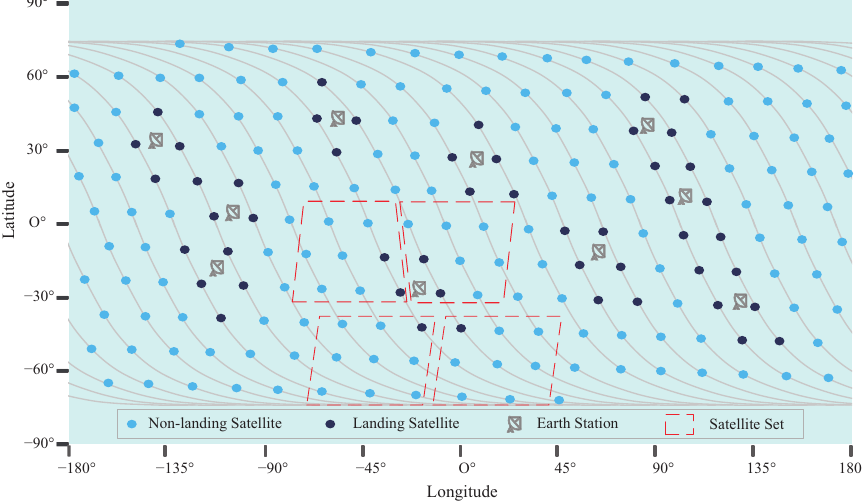
Figure 3. A diagram of satellite sets in a Walker